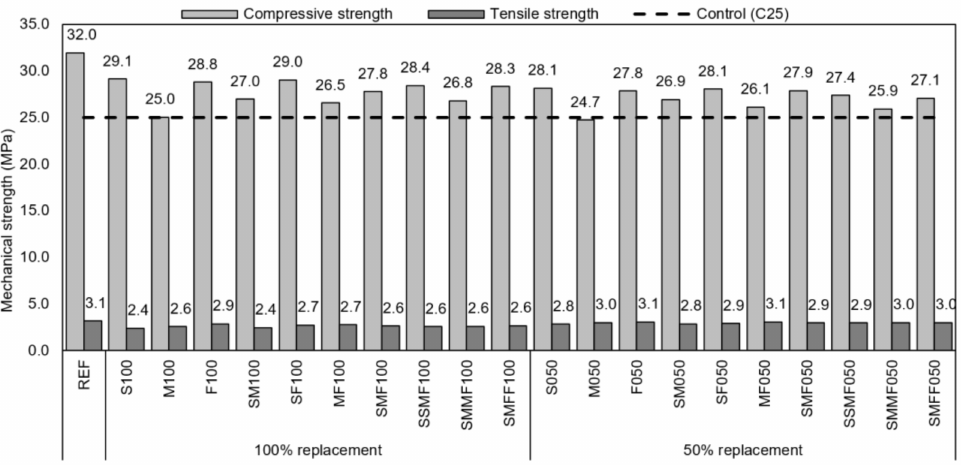
Figure 11. Mechanical strength of the